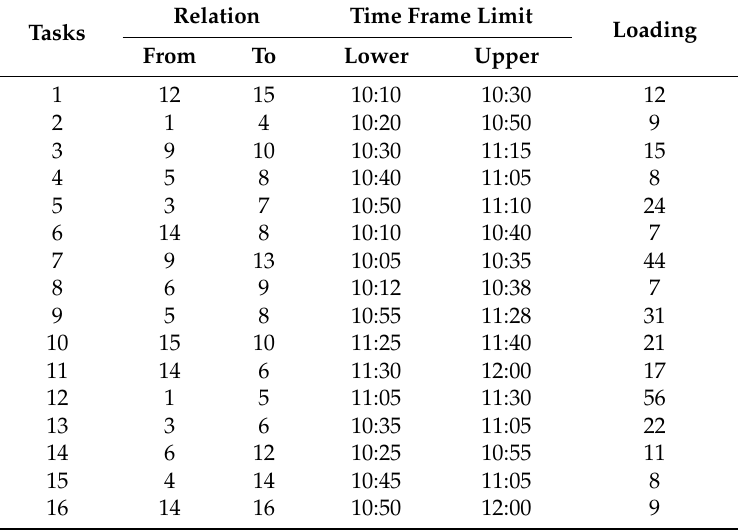
Table 7. Input parameters of the